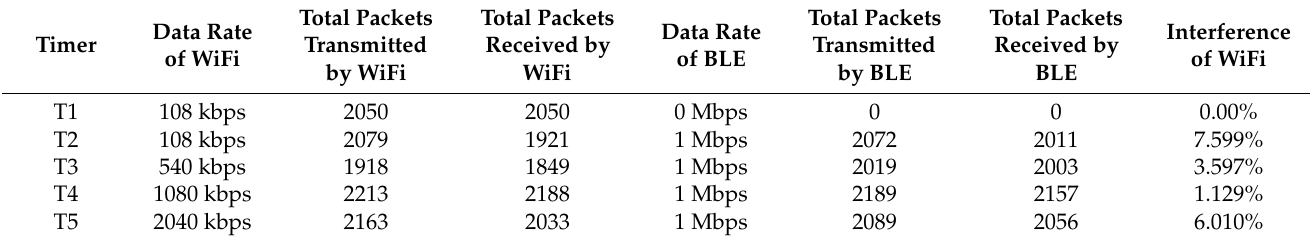
Table 3. Interference of WiFi and BLE.